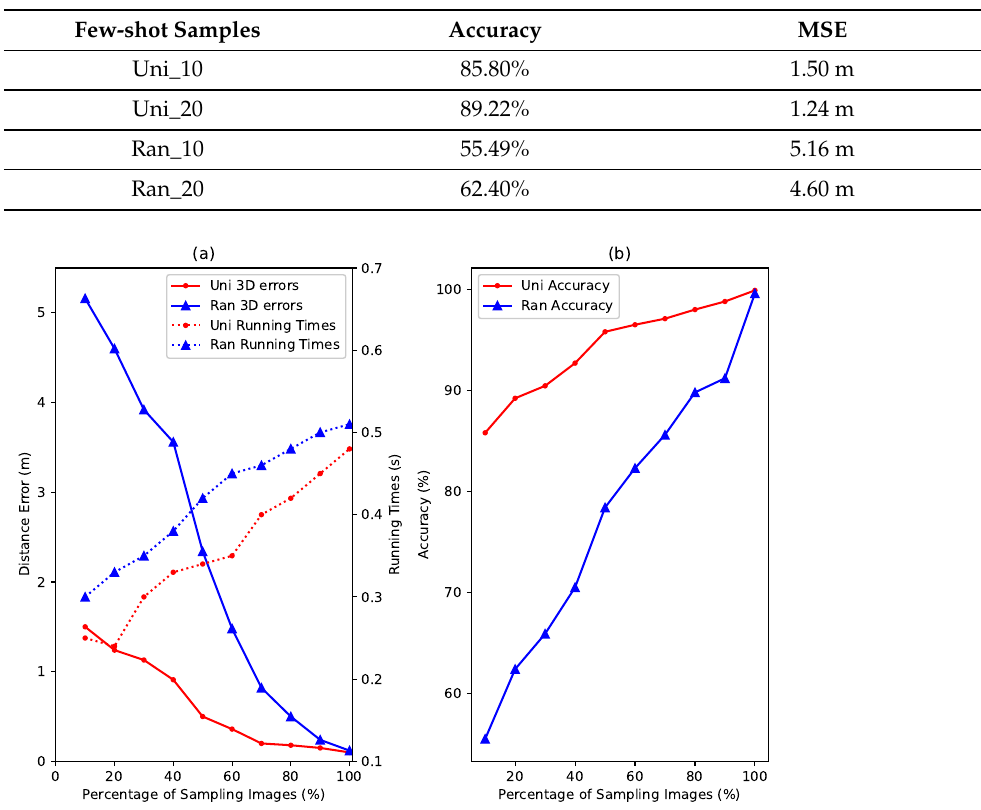
Figure 11. The CDF curves of 3D distance errors of different training sets for the proposed JVWL algorithm, in an experimental corridor environment. Table 4. Localization accuracy with different numbers and distribution of few-shot samples.